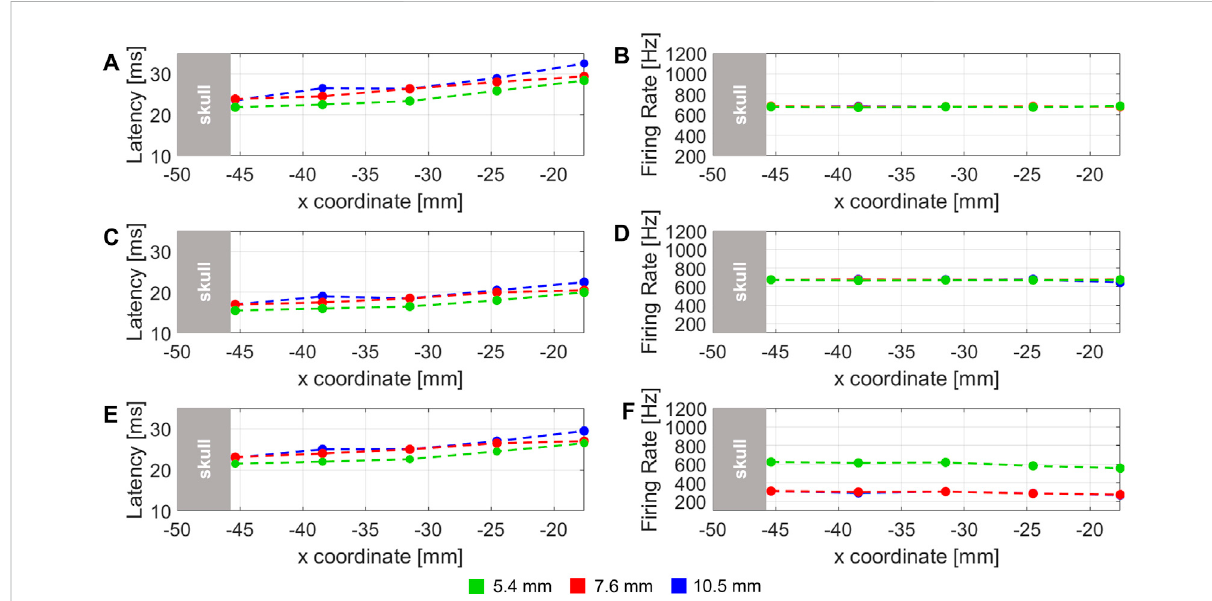
FIGURE 7 Latency of the stimulus and fi ring rate computed for three different DC: (A – F) are related to 40% DC, 60%, and 90% DC stimulus, respectively. The dashed lines represent the three different skull thickness considered of 5.4 (green), 7.6 (red) and 10.5 mm